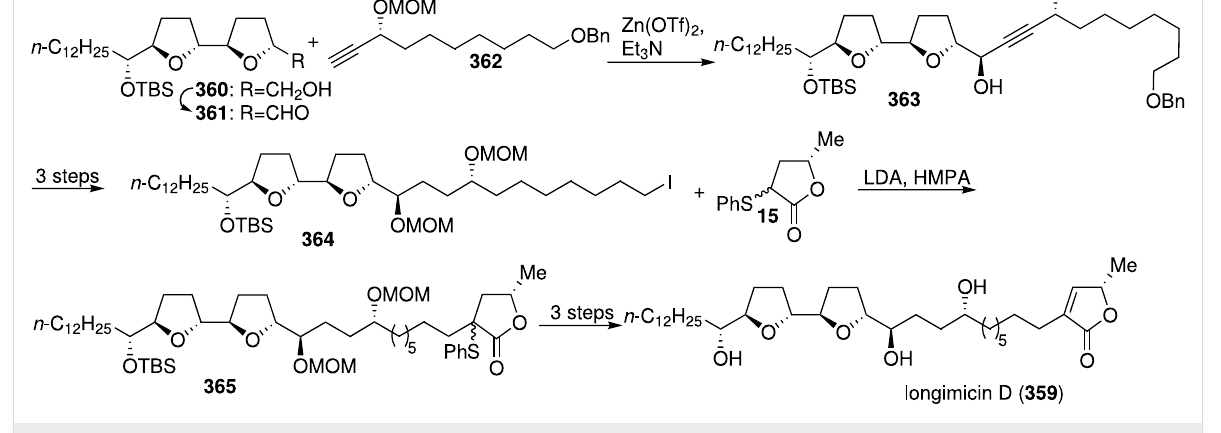
Scheme 51: Total synthesis of longimicin D by the group of Maezaki and Tanaka.